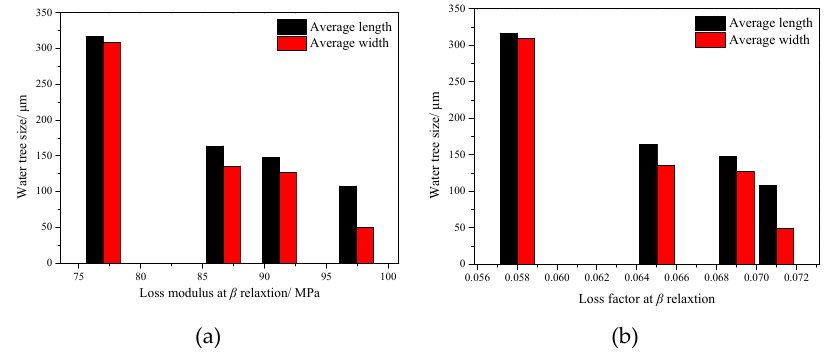
Figure 7. Relationship between β relaxation intensity and water tree size ( a ) loss modulus ( b ) loss factor.